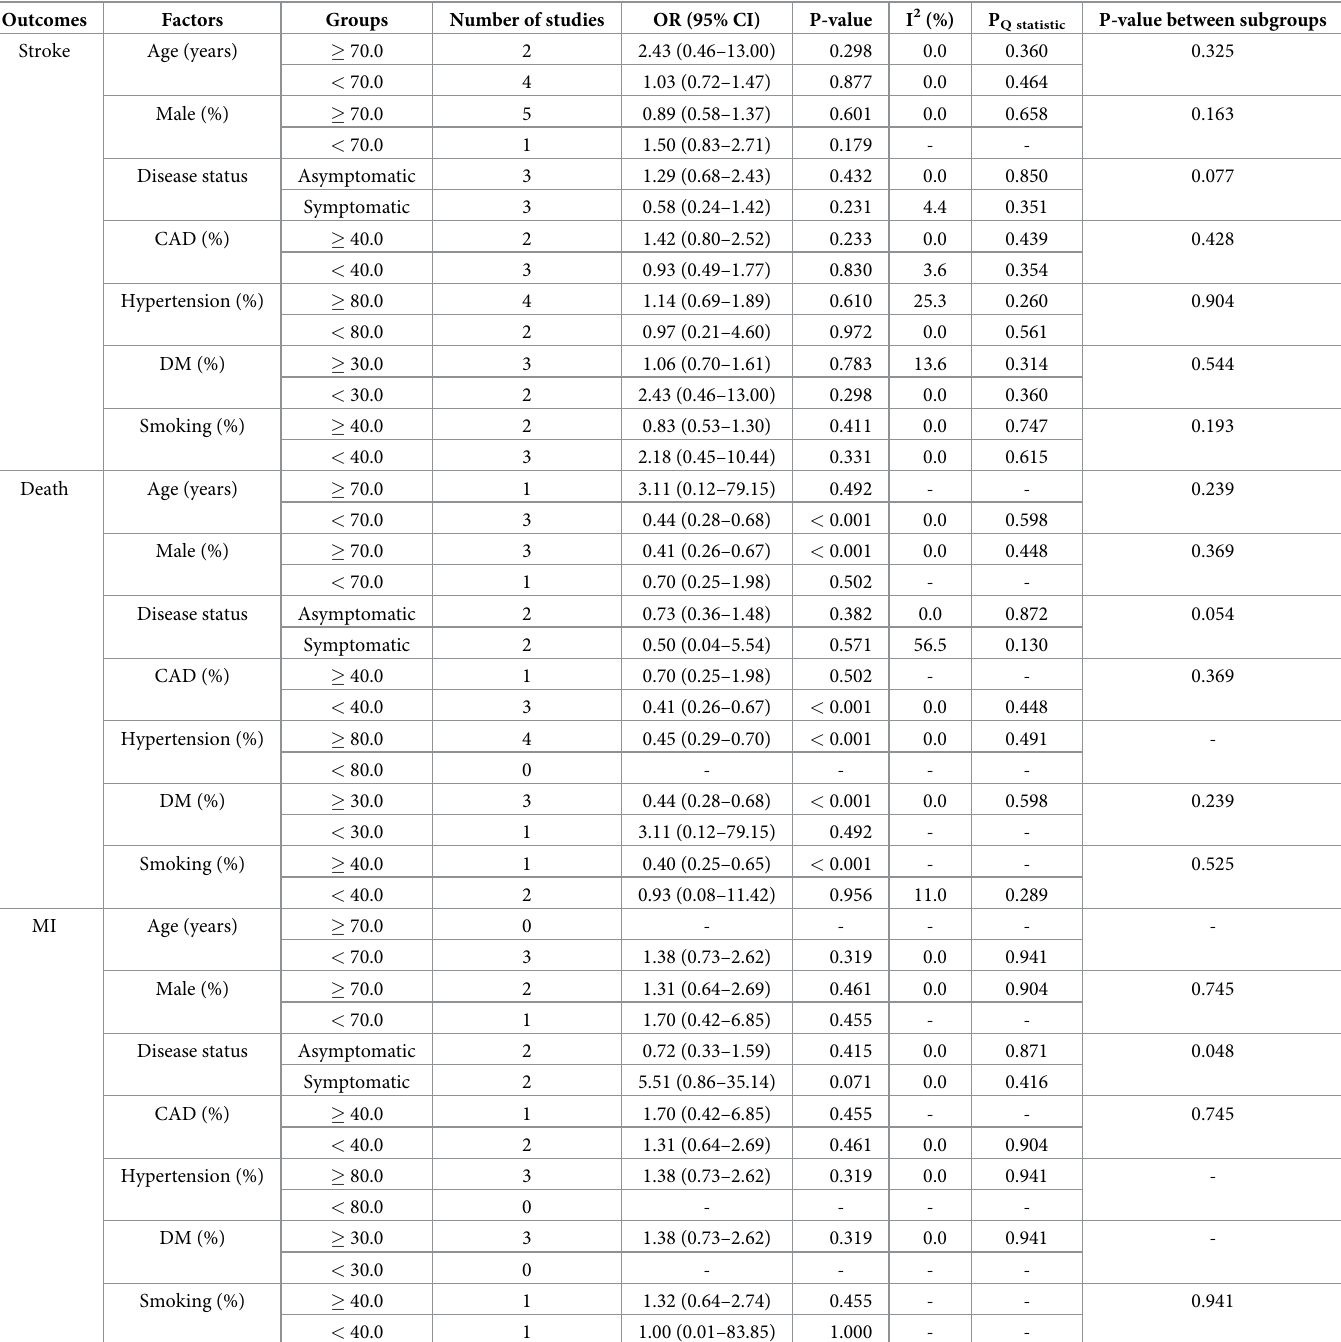
Table 3. Subgroup analyses for stroke, death, myocardial infarction, and major adverse cardiovascular